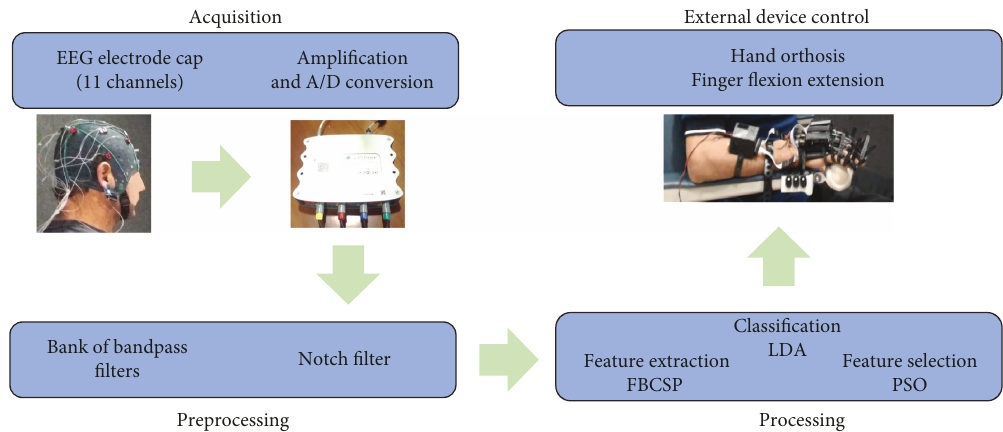
Figure 1: Stages of the BCI system employed for stroke patients ’